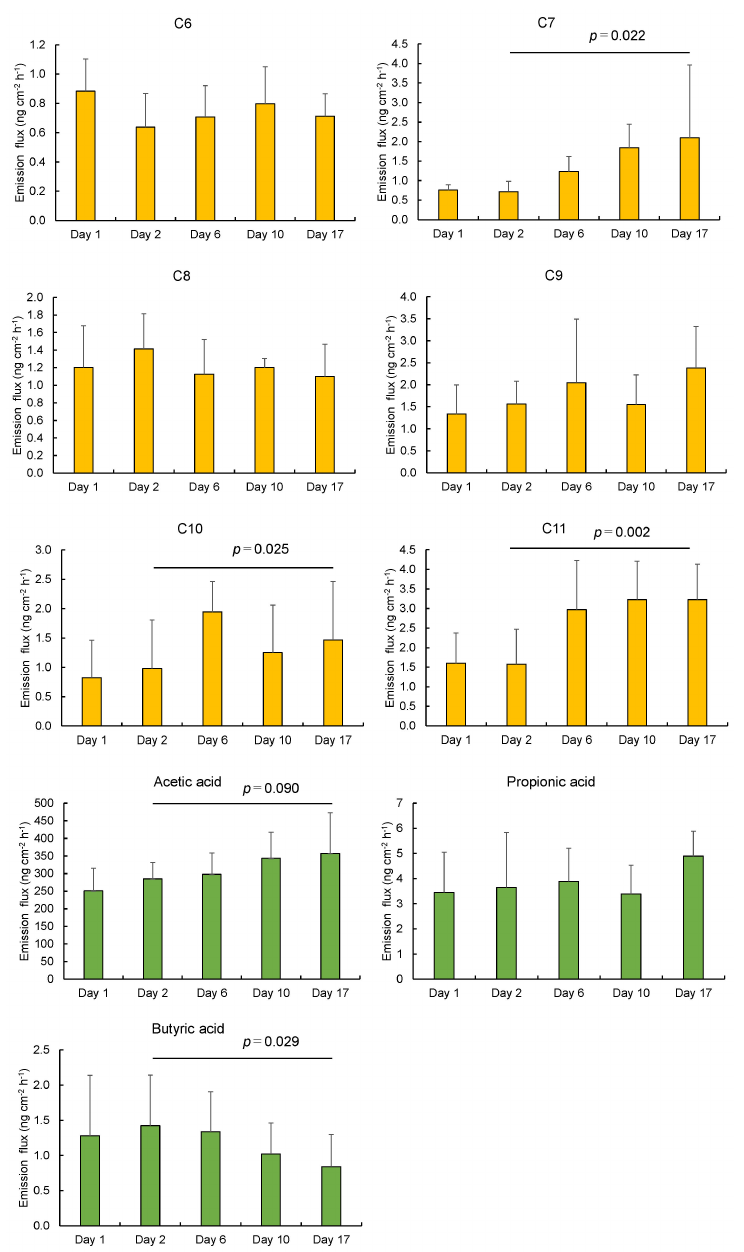
Figure 4. Variation in the fluxes of dermal emission of γ -lactones and SCFAs collected from the forearm of 6 healthy participants before (Day 1 and 2) and after (Day 6, 10, and 17) daily ingestion of lactulose. Jonckheere trend test was conducted for the values from Day 2 to Day